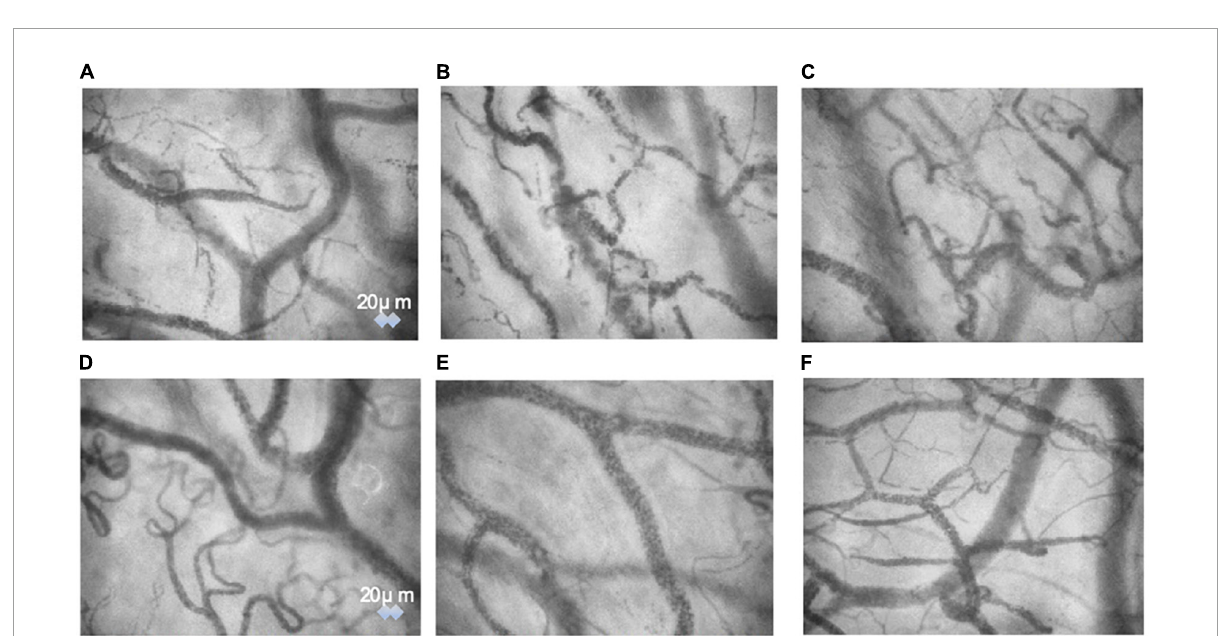
FIGURE7 The sidestream dark field images obtained through the videos of sublingual microcirculation. We have provided three images showing patients’ base state (A) , 10 min after anesthesia induction (B) , and 5 min after ephedrine administration (C) . The images for the phenylephrine group at the same time points have been provided as well (D–F)